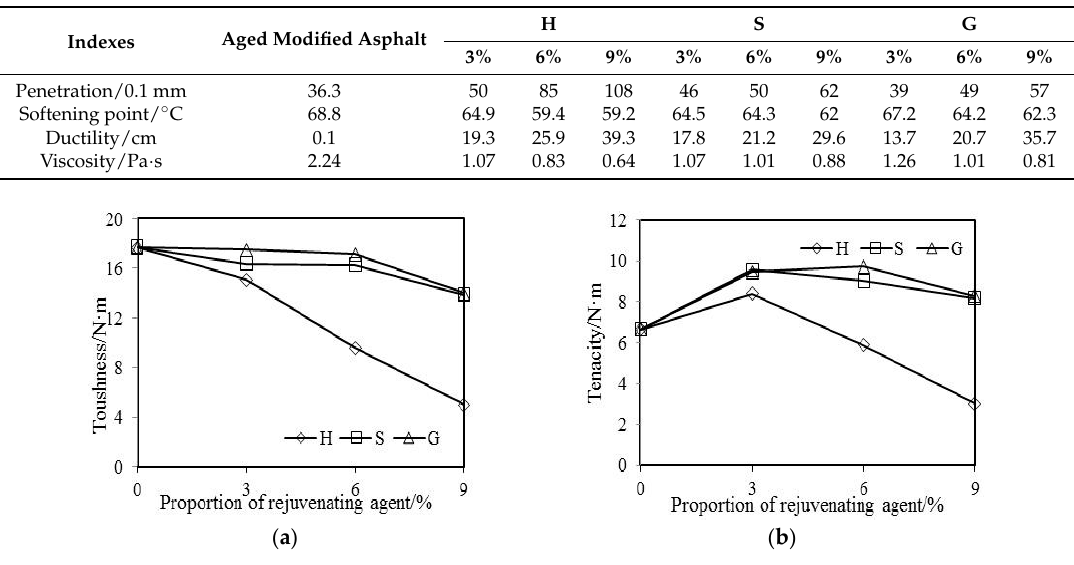
Table 6. The effect of rejuvenating agent on aged modified asphalt.